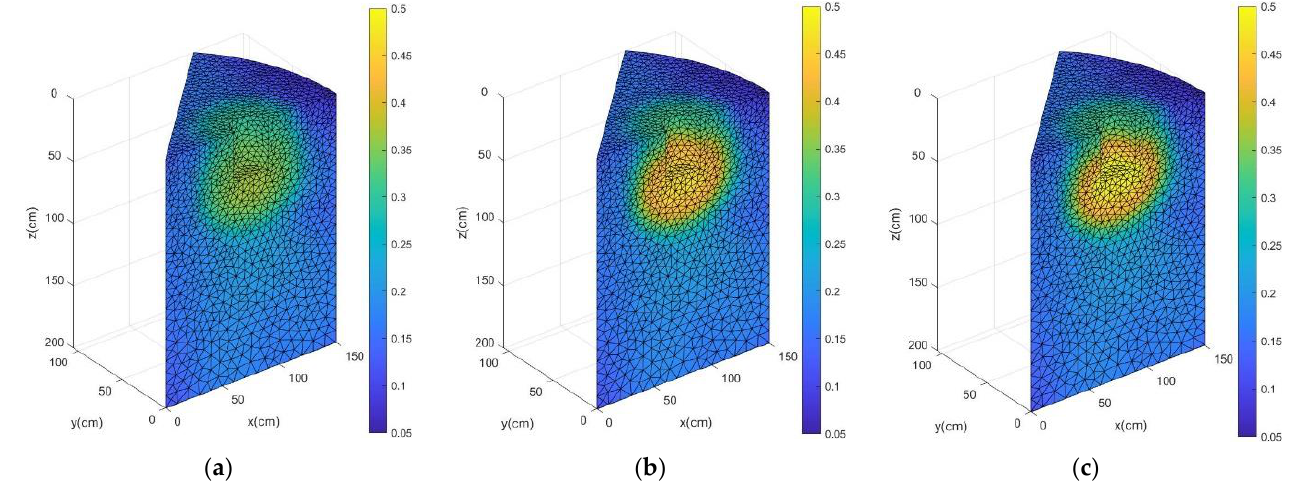
Figure 13. Simulation of soil moisture content under different irrigation amounts. ( a ) Irrigation amount: 200 L; ( b ) Irrigation amount: 300 L; ( c ) Irrigation amount: 400 L. Table 10. Calculation of statistical indexes for soil moisture under different irrigation amount.